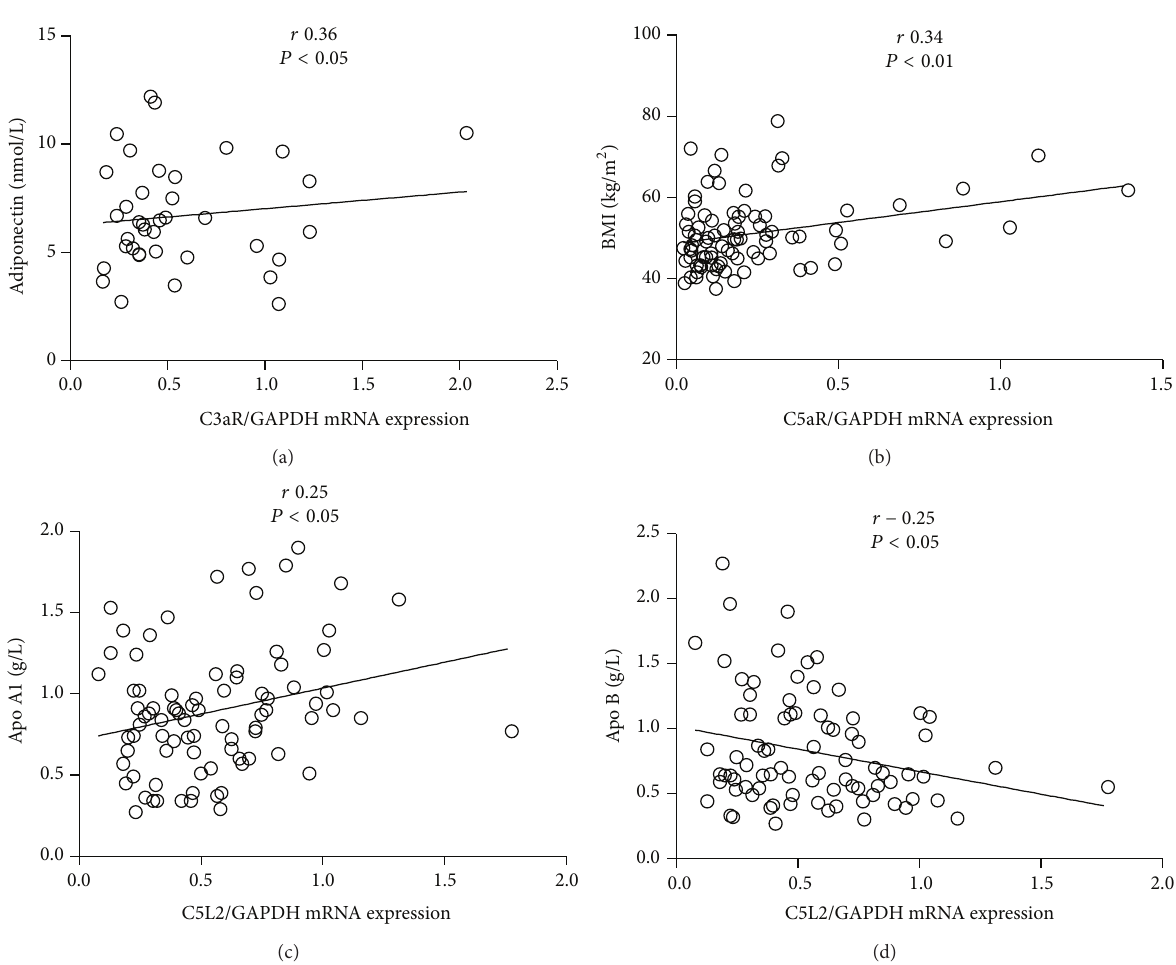
(Qiagen Inc, Mississauga, ON, Canada). Total RNA